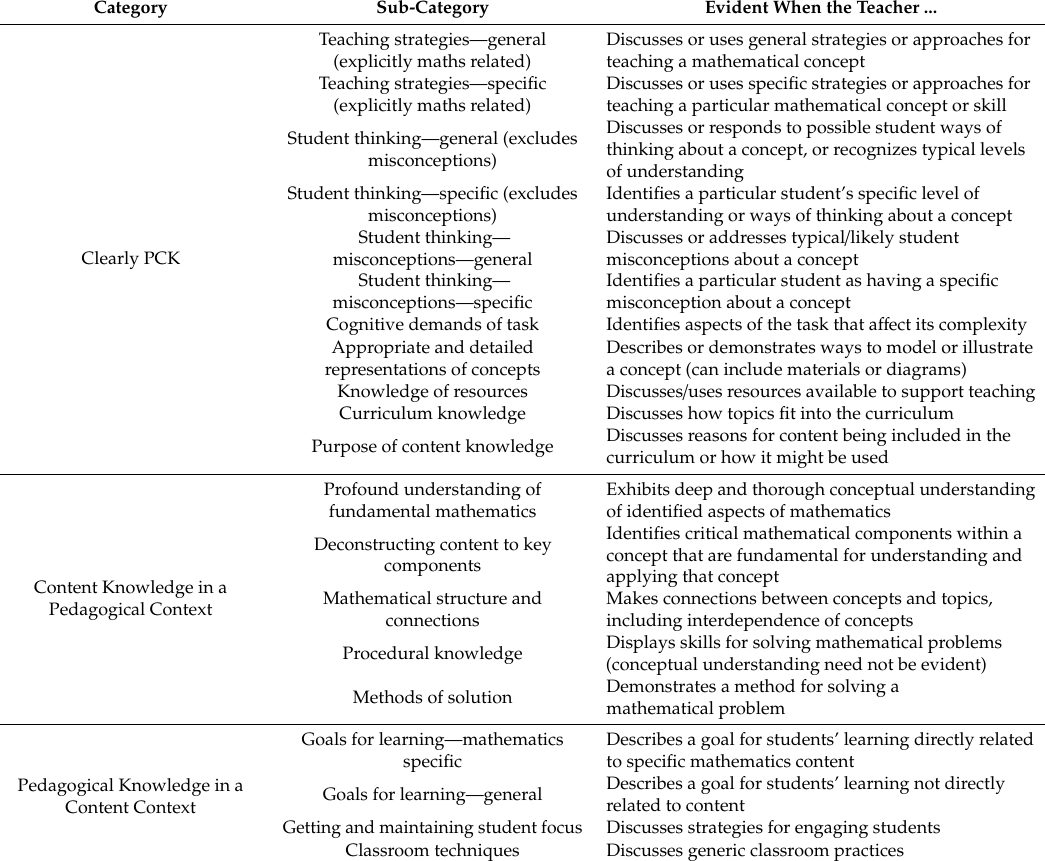
Table A1. Chick, Baker et al. Framework for Analyzing MPCK [33] (p.